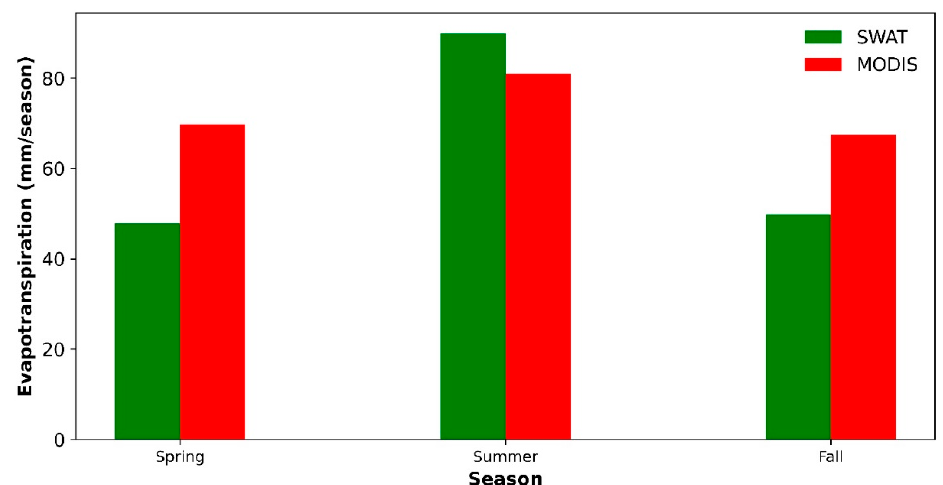
Figure 10. Comparison of long-term average seasonal SWAT-simulated vs. MODIS evapotranspira- tion data.